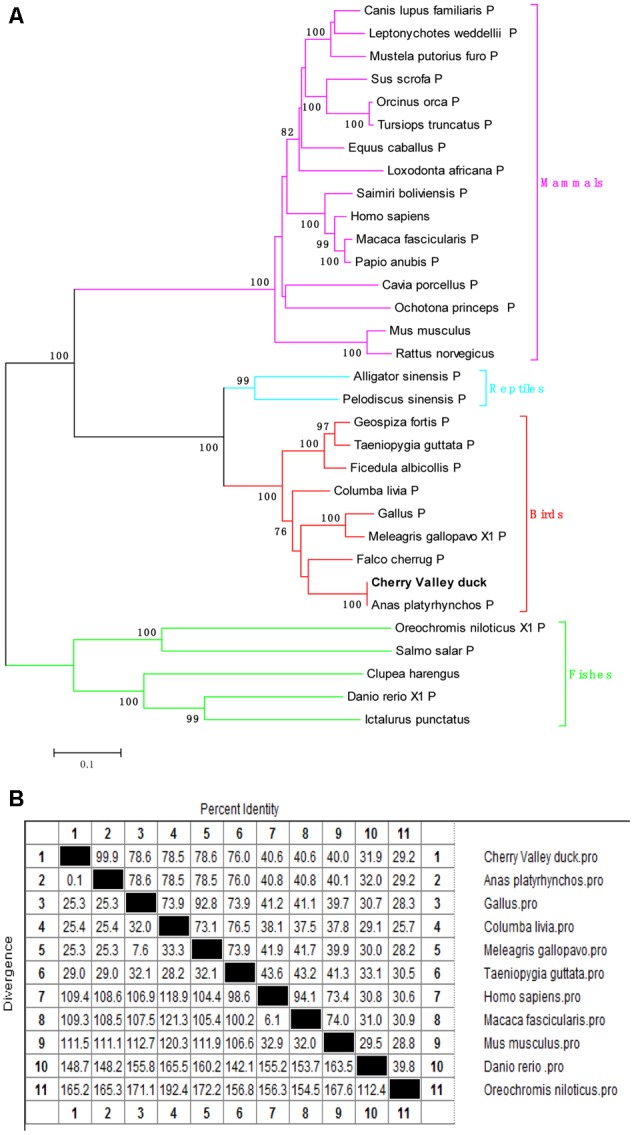
(A) A phylogenic tree based on CIITA between Cherry Valley duck and other species amino acid sequence. Neighbor-joining tree was generated using MEGA 5.0, and a 1000 bootstrap analysis was performed. The scale bar was 0.1. GenBank accession numbers were shown in Table 2. (B) Homology analysis of Cherry Valley duck CIITA in amino acid sequence (% amino acid sequence identities). Percent amino acid sequence homology was calculated by MegAlign software with Clustal W method. GenBank accession numbers were shown in Table 2.